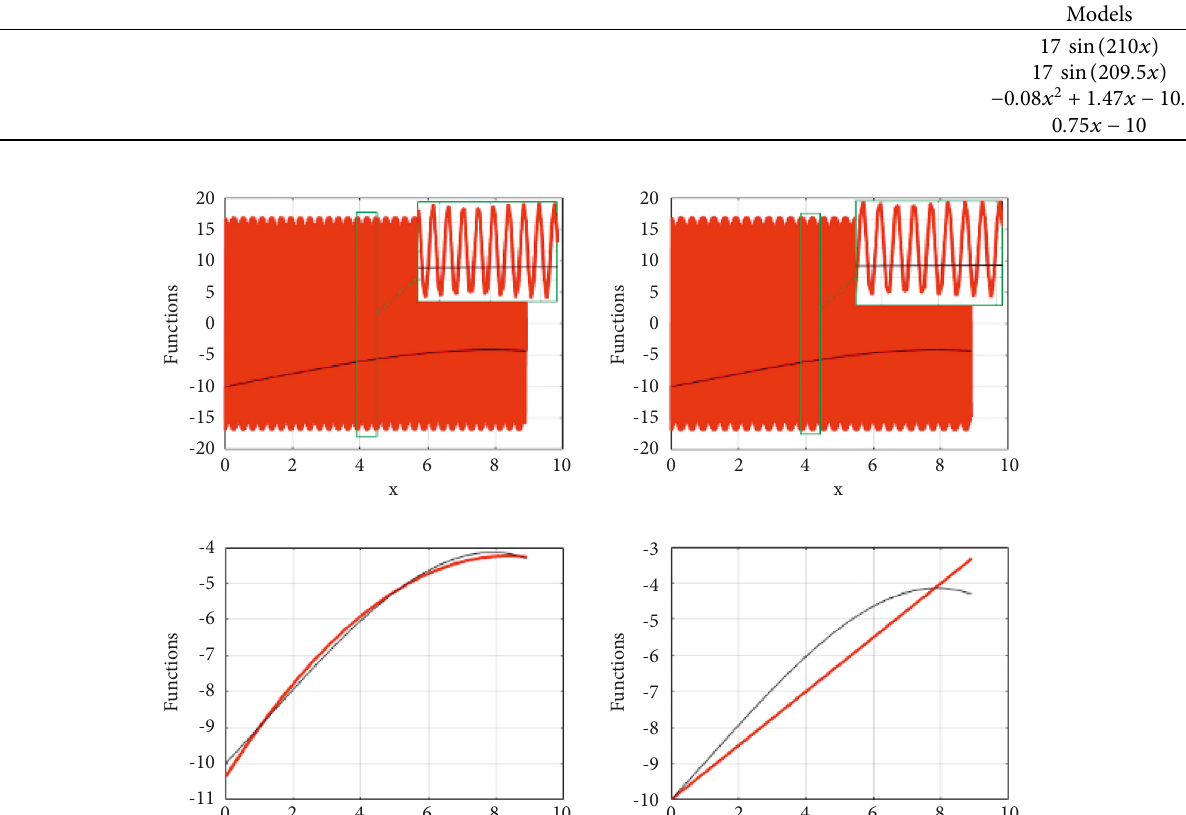
Table 1: The four candidate models to fit the data generated by (14).